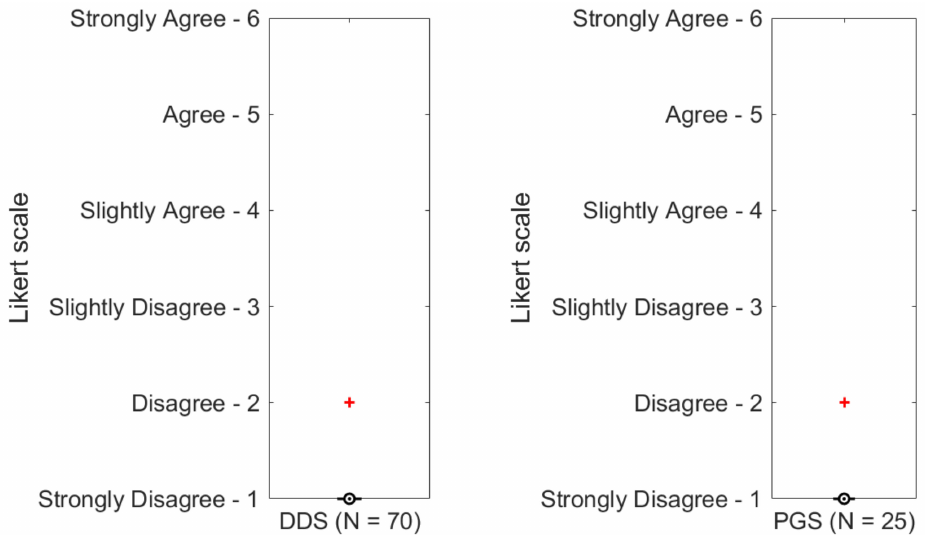
Figure A1. Results of the question, if the participants perceived any glare during the field test with an evaluation of a 6-point Likert scale, where one corresponds to a strong disagreement of the question and 6 a strong agreement. The left boxplot displays the results for the DDS participants and the right boxplot for the PGS participants. The bullet point indicates the median and the red crosses are the outliers. This question was asked to the participants after the study took